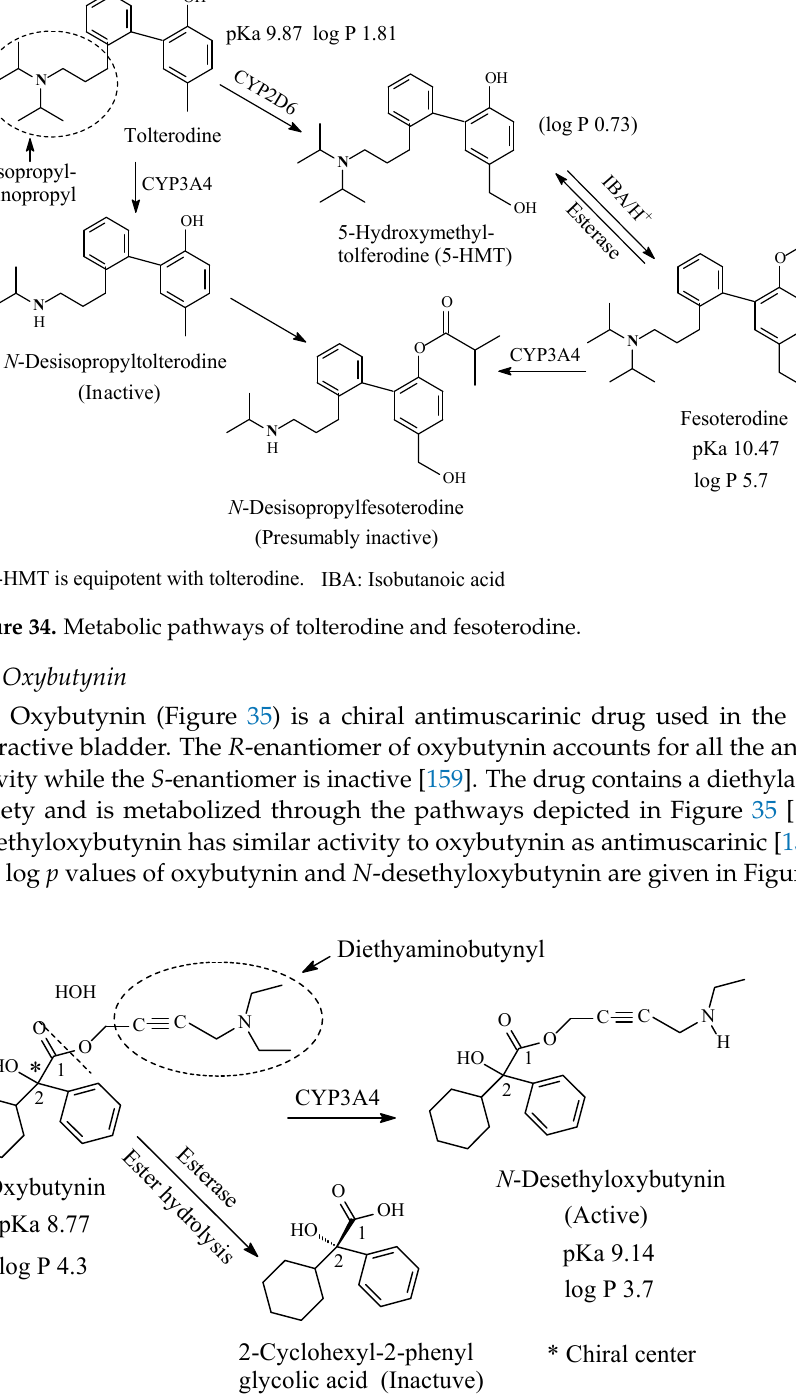
(Active) Figure 36. Metabolism of ivabradine. 11. Drugs That Act as Enzyme Inhibitors 11.1. Sildenafil Sildenafil (Figure 37) is a member of a class of medications called phosphodiesterase (PDE) inhibitors. It is used to treat erectile dysfunction in men as well as pulmonary arte- rial hypertension [167]. It contains a heterocyclic tertiary methylamino moiety, which rep- resents the site of metabolism upon N -demethylation to give N -desmethylsildenafil (Fig- ure 37) [168–171]. The metabolite possesses a PDE5 selectivity that is similar to the parent sildenafil molecule and in vitro potency for PDE approximately 50% that of the parent drug; it accounts for 20% pharmacologic activity of sildenafil [171]. The pKa and log p values of sildenafil and N -desmethylsildenafil are given in Figure 37.